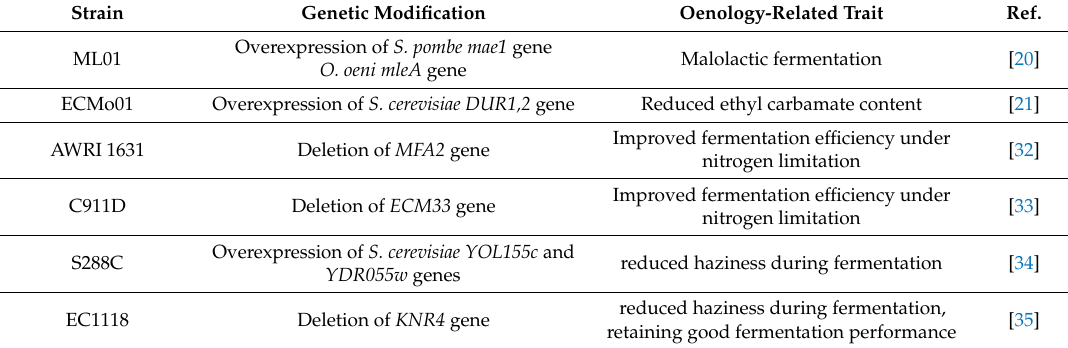
Table 2. Selected metabolically-engineered yeast strains and their oenology-related phenotypes. Strain Genetic